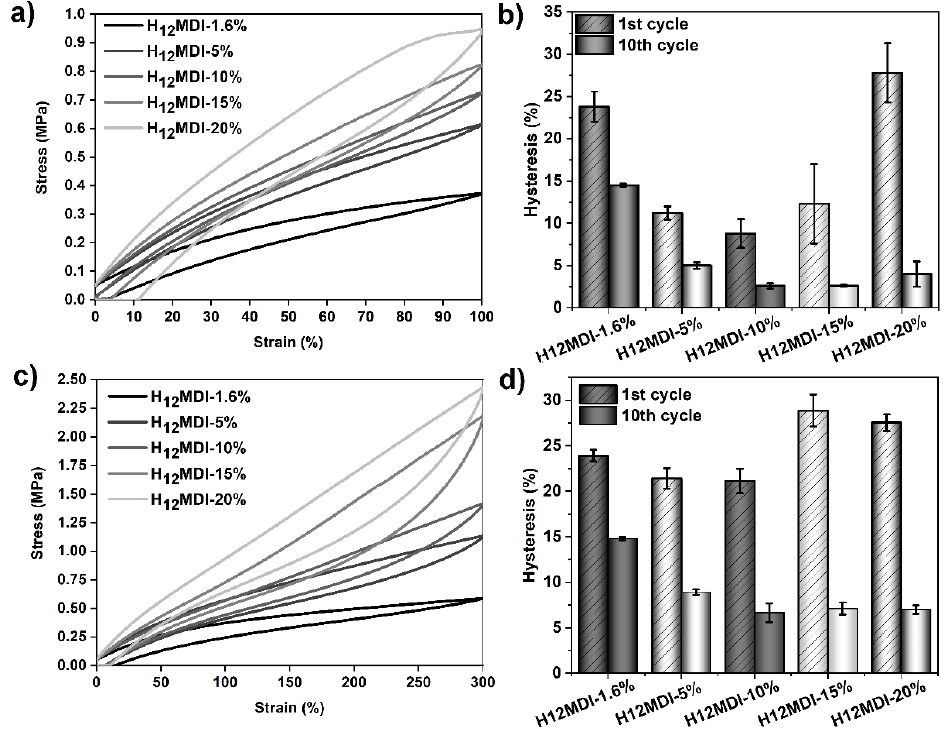
Figure 8. Results of tensile hysteresis measurements on PSU elastomers synthesized from H 12 MDI with HS contents between 1.6% (copolymer) and 20%. ( a ) 100%-hysteresis curves (1st cycle) and corresponding mean hysteresis values ( b ) of the 1st and 10th cycles. ( c ) 300%-hysteresis curves (1st cycle) and corresponding mean hysteresis values of the elastomers ( d ) at the 1st and 10th cycles. The error bars represent the standard deviation of three repeated measurements. Hysteresis at 100% strain in the 1st cycle decreases from approximately 24% (1.6% HS content) to 9% (10% HS content) and increases again to approximately 28% at 20% HS content. Hysteresis in the 10th cycle decreases from approximately 15% (1.6% HS content) to 3% (10% HS content) and remains constant with increasing HS content. A similar but less pronounced trend for the hysteresis values appears when the PSU elastomers are repeatedly stretched to 300%. Table 3. Influence of HS content on tensile hysteresis for PSU elastomers synthesized from H 12 MDI with HSs ranging from 1.6% (copolymer) to 20%. The values are given for the first three cycles and the last (10th) cycle at 100% and 300% strain, respectively. The given values are the mean values from three repeated measurements and were rounded to integers.